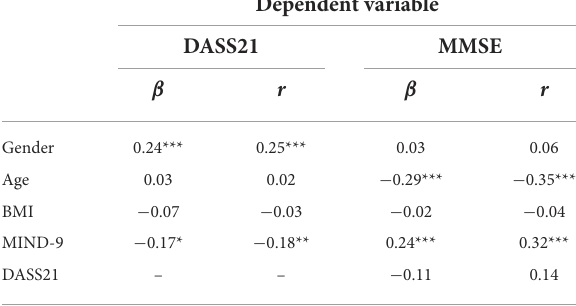
TABLE 3 Standard regression analyses of DASS21 and MMSE on MIND-9, gender, age and BMI.